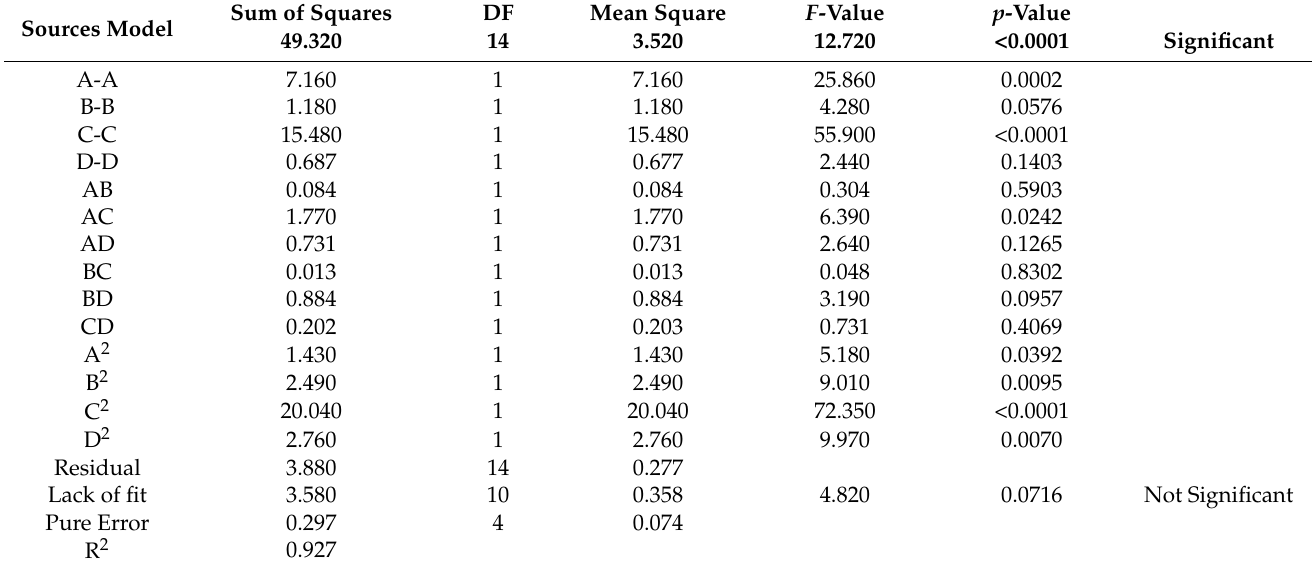
Table 2. Variance analysis of extraction yield using the regression